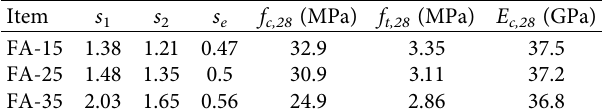
Table 4: Model parameters for the mechanical properties of LHP cement